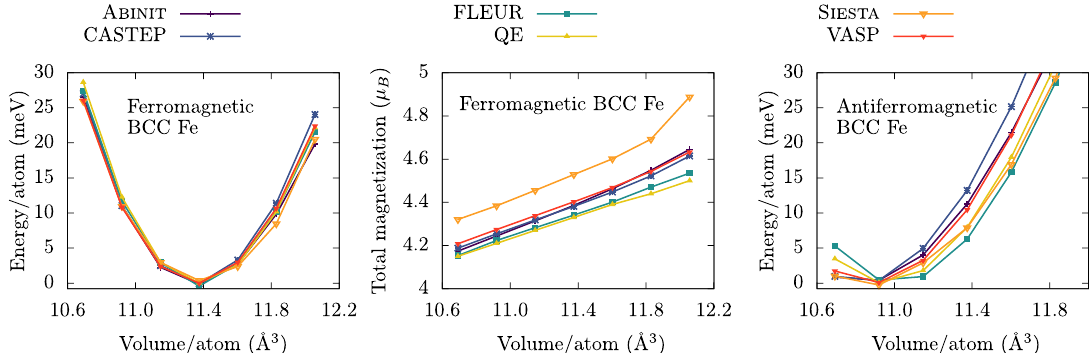
Fig. 8 EOS and total magnetization for BCC Fe. Results obtained with the code-agnostic EquationOfStateWork fl ow . The left panel reports the EOS obtained with a ferromagnetic initialization of the atomic moments. The corresponding total magnetization is reported for each volume in the central panel. The right panel reports the EOS obtained with an anti-ferromagnetic initialization of the atomic moments. The label QE stands for Quantum ESPRESSO. Results are missing for BigDFT, CP2K, Gaussian, NWChem, and ORCA (see Supplementary Table 2 for more details).